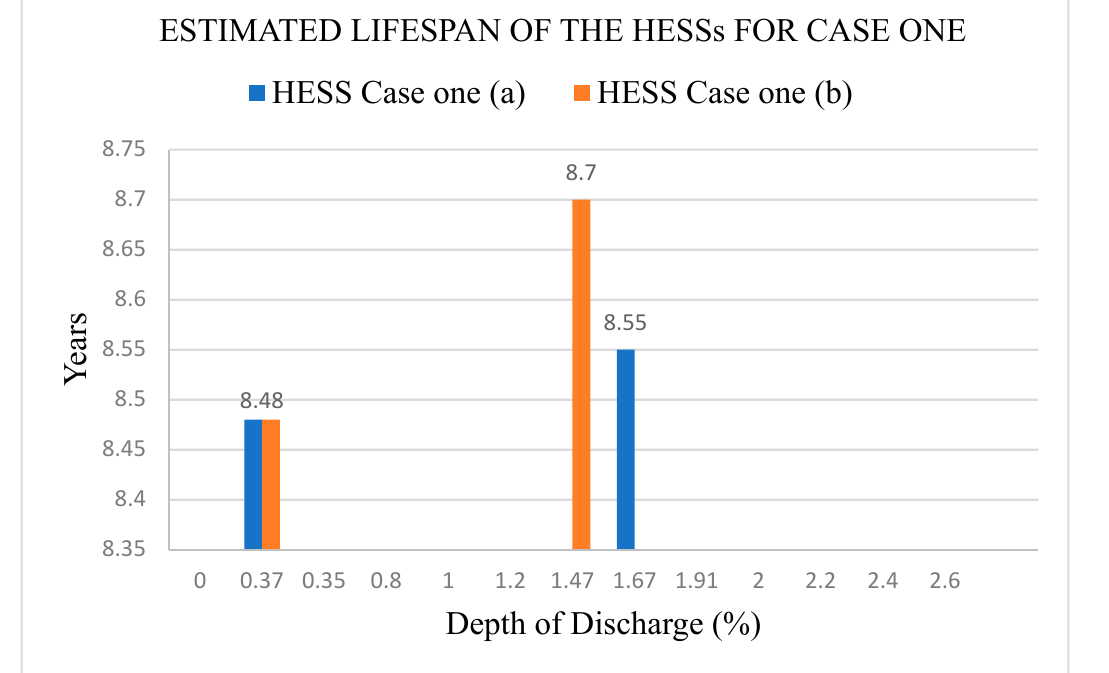
Figure 22. The estimated lifespan of the proposed HESS for cases one and two. Table 8. Results summary of the proposed HESS.